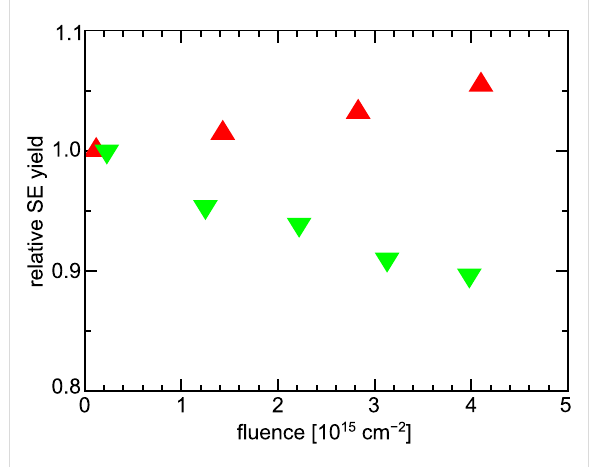
Figure 3: Comparison of contrast evolution in a standard HV and the used UHV HIM. The SE yield, which is proportional to the gray level in SE images, is plotted against the total dose for a HV system (green pointing down triangles) and the used UHV HIM (red pointing up trian- gles).